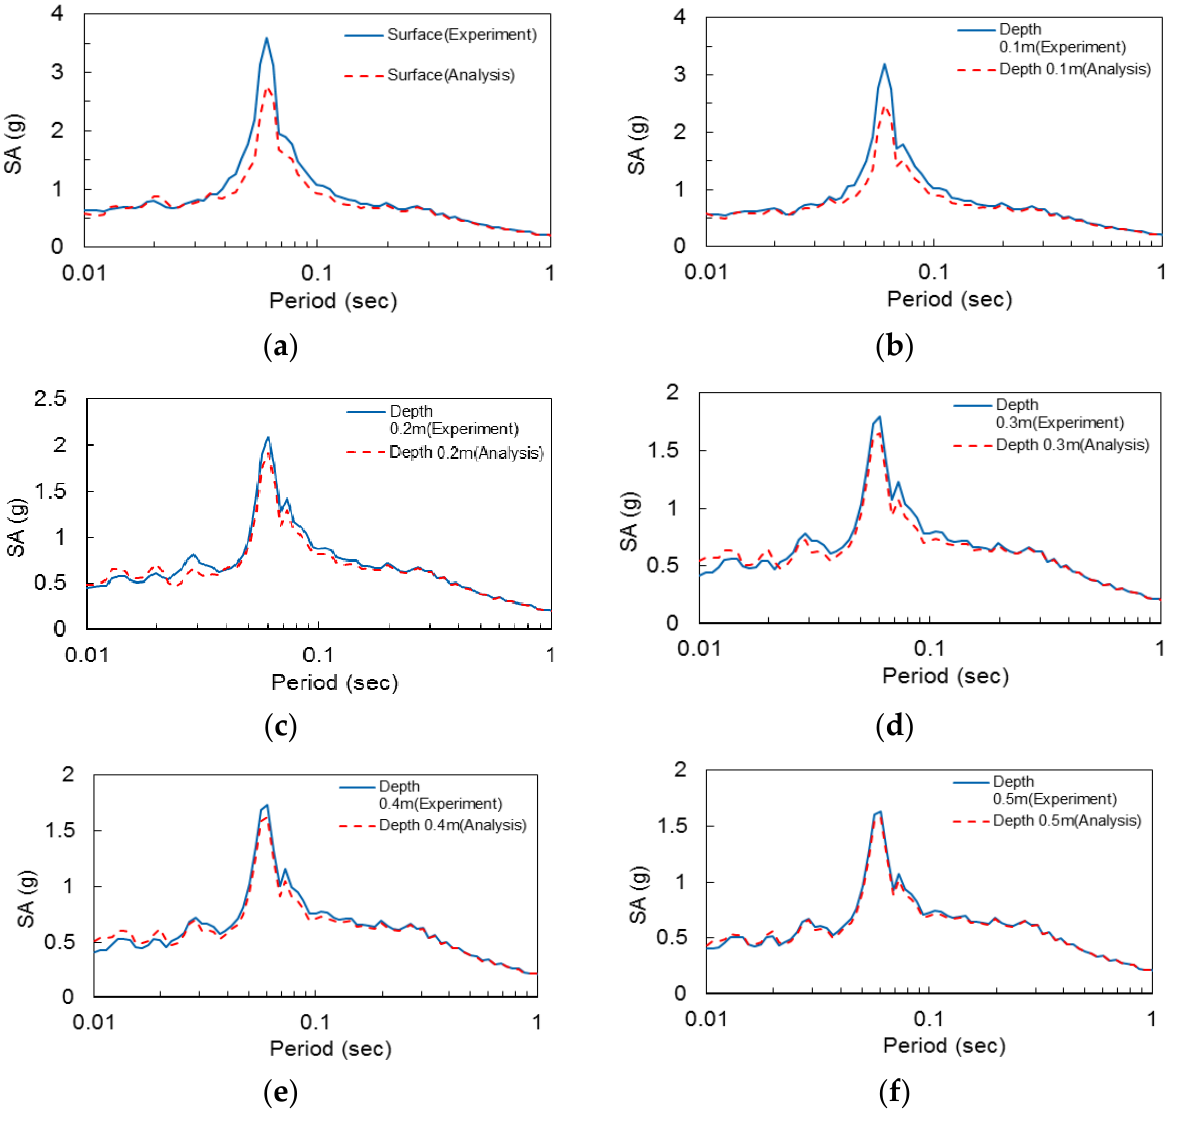
Figure 17. ( a ) SA by artificial wave at surface; ( b ) SA by artificial wave at 0.1 m depth; ( c ) SA by artificial wave at 0.2 m depth; ( d ) SA by artificial wave at 0.3 m depth; ( e ) SA by artificial wave at 0.4 m depth; ( f ) SA by artificial wave at 0.5 m depth.